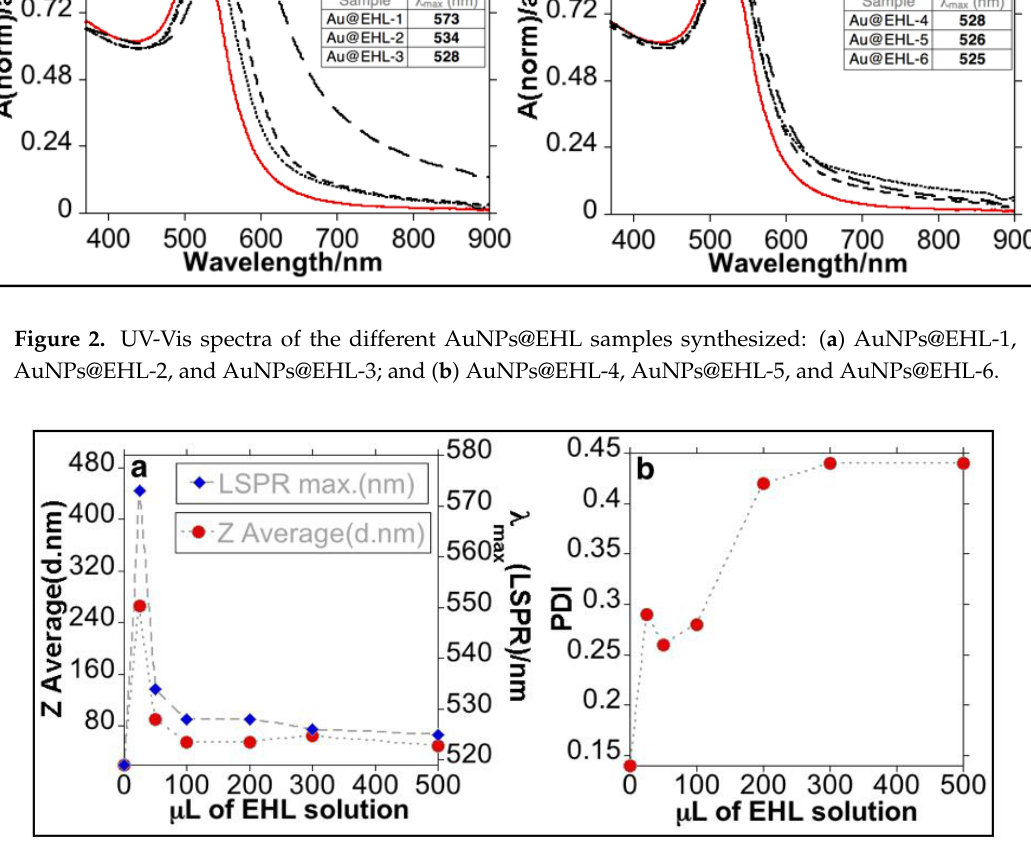
Figure 2. UV-Vis spectra of the different AuNPs@EHL samples synthesized: ( a ) AuNPs@EHL-1, AuNPs@EHL-2, and AuNPs@EHL-3; and ( b ) AuNPs@EHL-4, AuNPs@EHL-5, and AuNPs@EHL-6.